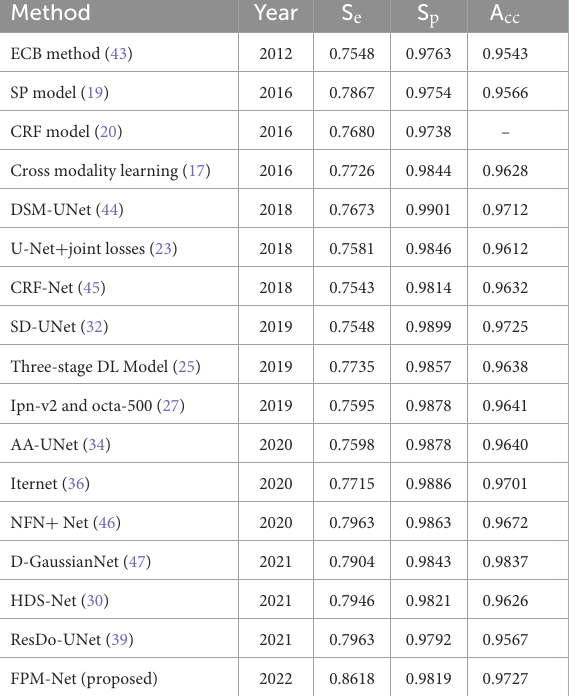
TABLE 3B The comparison of the CHASE-DB1 data set’s segmentation results using various segmentation techniques.